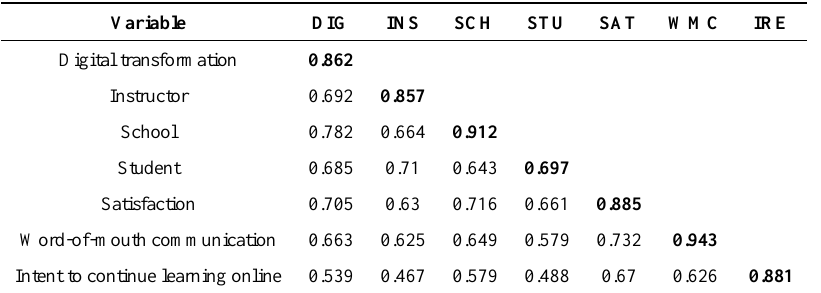
Table 3. Discriminant validity test (Fornell-Lacker)